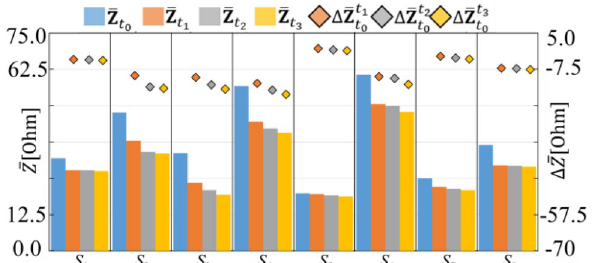
Figure 7. Comparison of average measured impedance Z , delta measured impedance (cid:31) Z